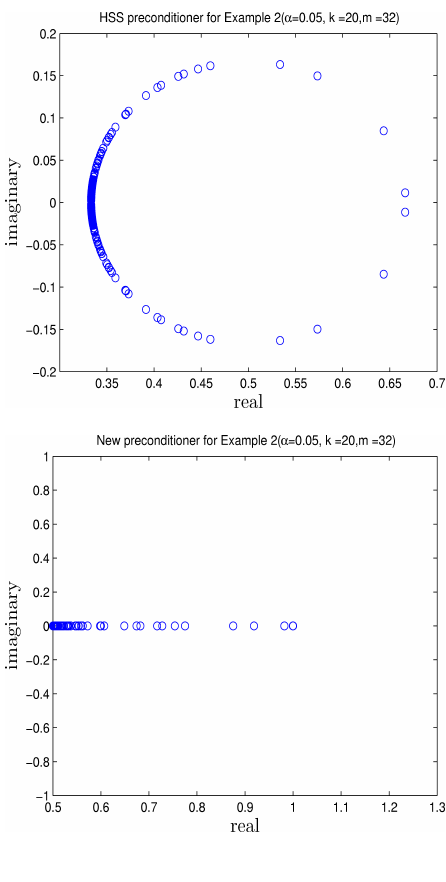
Fig. 2. The eigenvalue distributions of unpreconditioned matrix, the preconditioned matrices P − 1 Example 2 with k = 20, m = 32